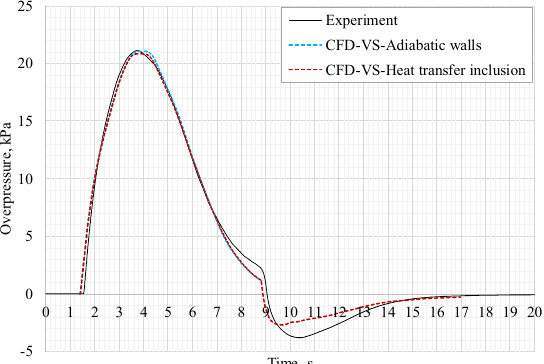
. m = 11.37 g/s, Number